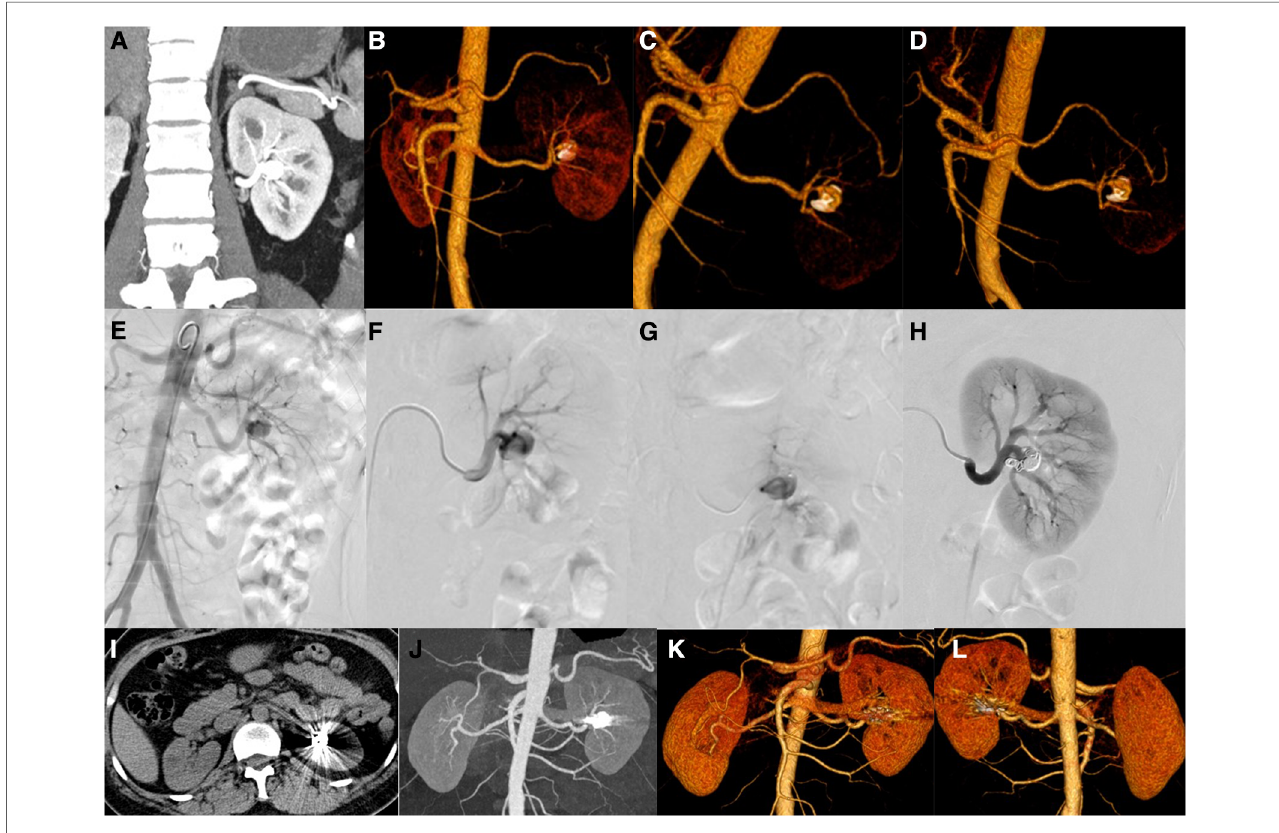
FIGURE 2 Patients no. 1 with renal aneurysms: ( A – D ) Computed tomography (CT) showed an aneurysm (1.4 cm×1.2 cm) at the proximal end of the posterior segment of the left renal artery, accompanied by mural thrombus and peritumoral calci fi cation, and several cysts in the right kidney and liver. ( E,F ) An angiography of the left renal artery is performed, and frontal imaging (digital subtraction angiography) showed that the left renal artery was equivalent to the artery adjacent to the left renal pelvis and showed a tumor-like expansion (approximately 1.1×1.4 cm). The left renal artery aneurysm is embolized with a microcoil and medical glue through a microcatheter, and the left renal artery angiography is repeated. ( I – L ) Three months after the operation, the CT scan showed that the posterior segment of the left renal artery showed a metallic fi xation, which showed post-embolization